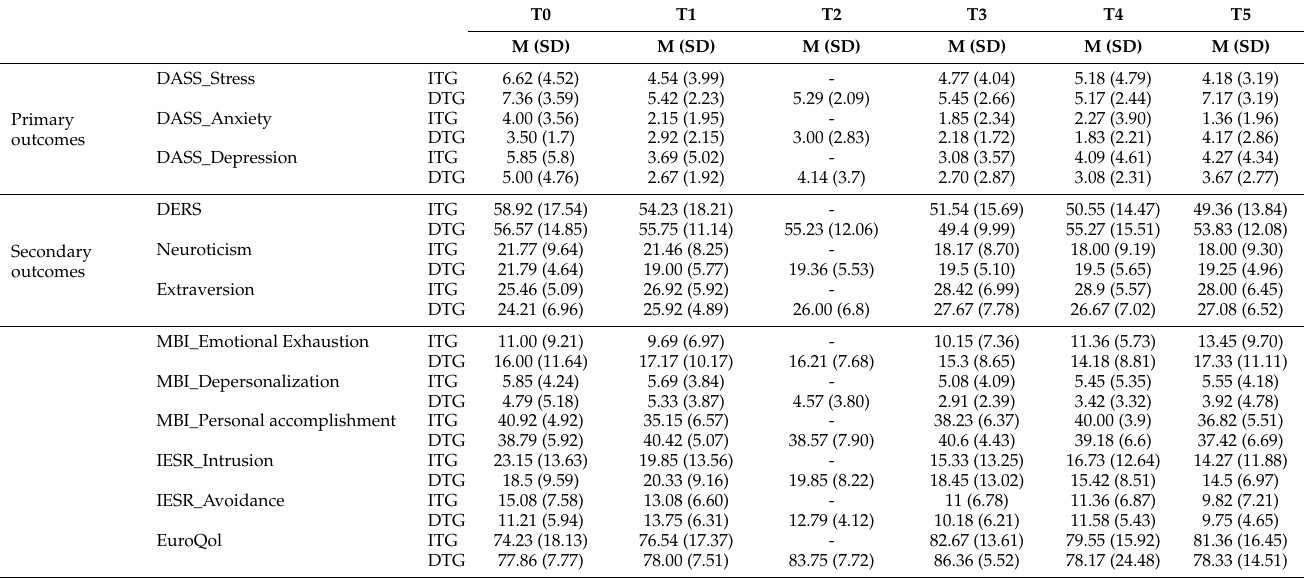
Table 2. Means and standard deviations of the variables over time in the immediate and delayed treatment groups. (N =